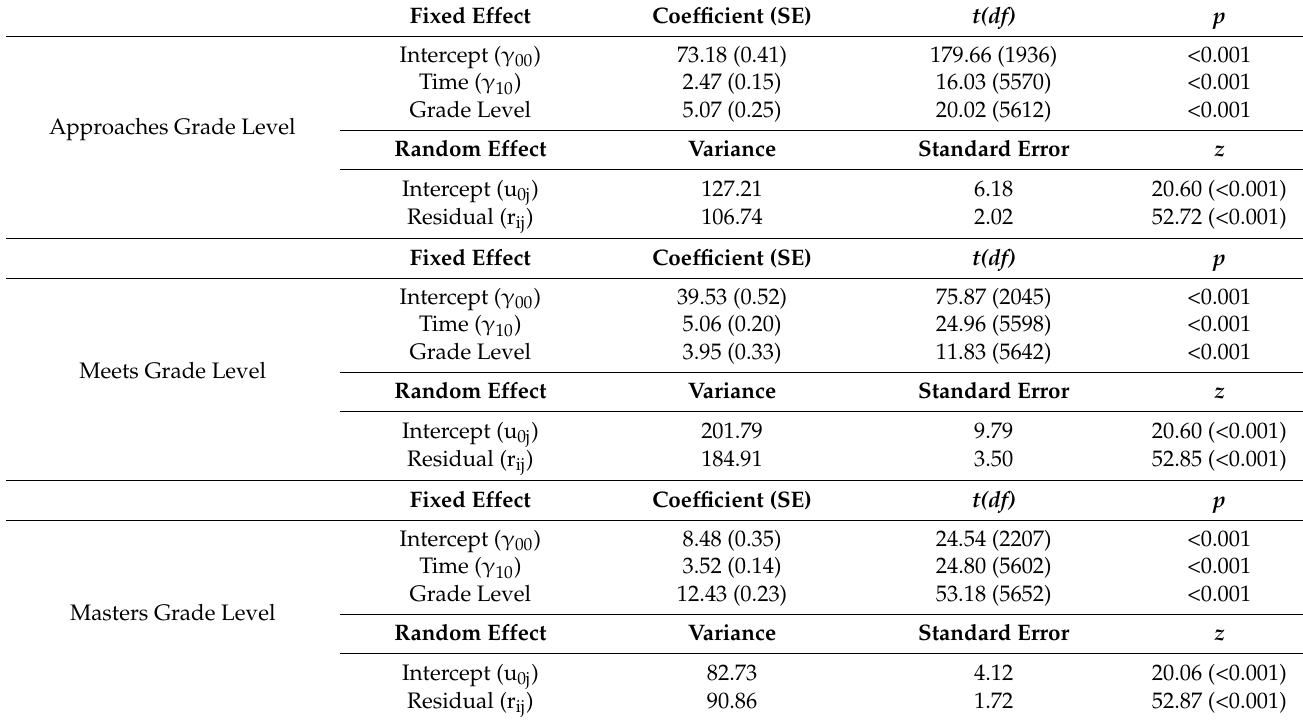
Table 3. Parameter estimates of fixed and random effects of Model 1 by performance